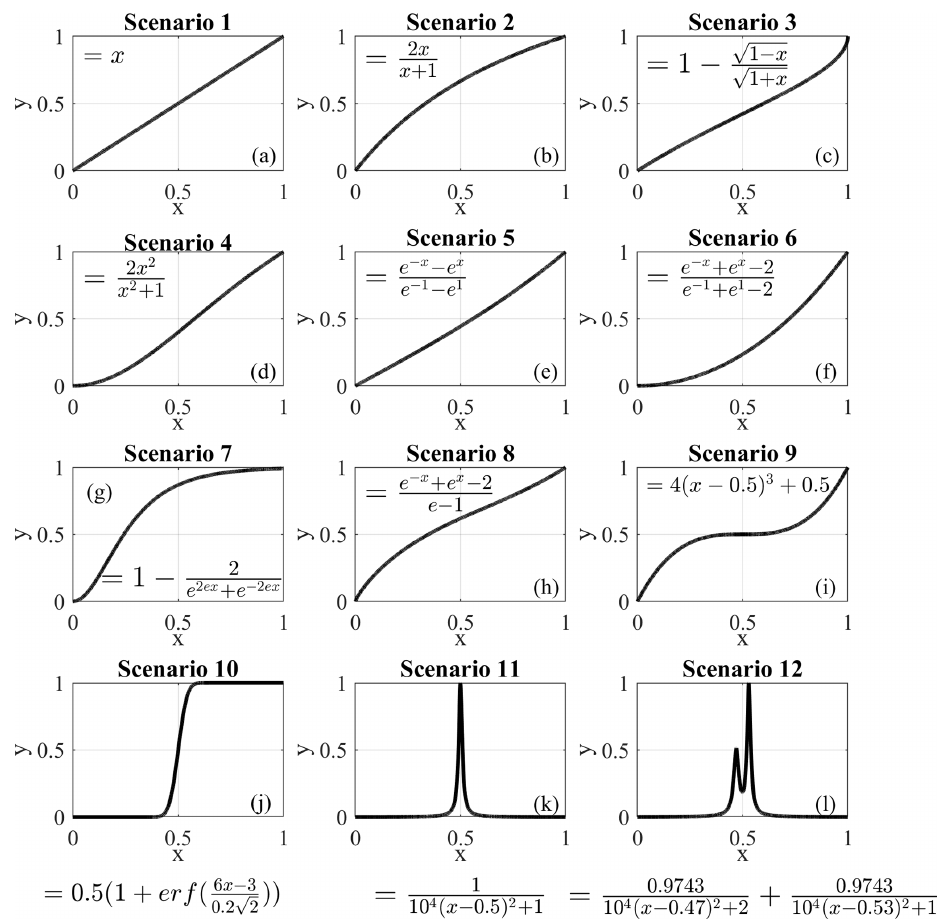
Figure 1. Configuration of all synthetically generated scenarios.